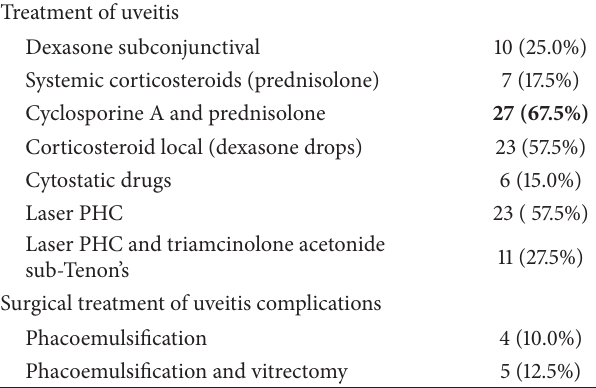
Table 2: Medical treatment, laser photocoagulation, and surgical methodsusedin treatmentof ocularinvolvement and complications of Behcet’s disease ( 𝑁 = 40